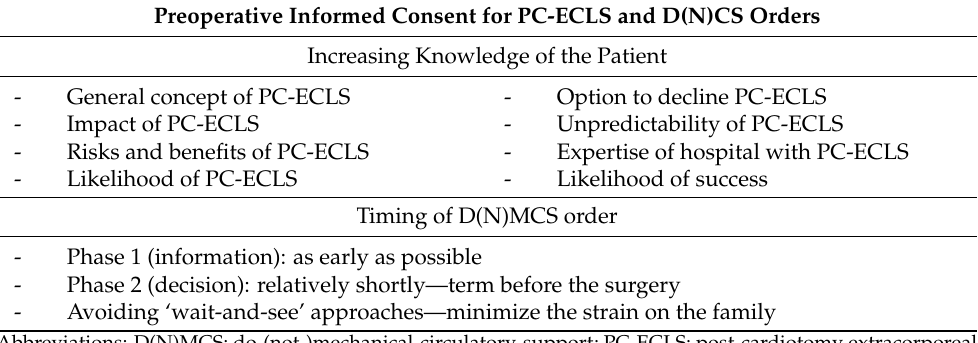
Table 2. Key points for PC-ECLS informed consent and D(N)MCS